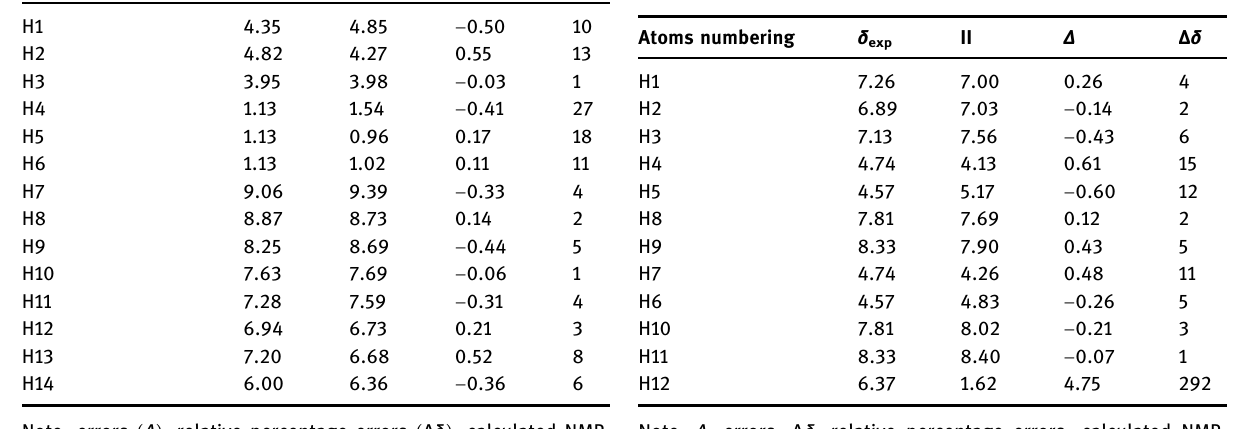
Table 7: Experimental ( δ exp ) and calculated chemical shifts ( I ) for compound 1